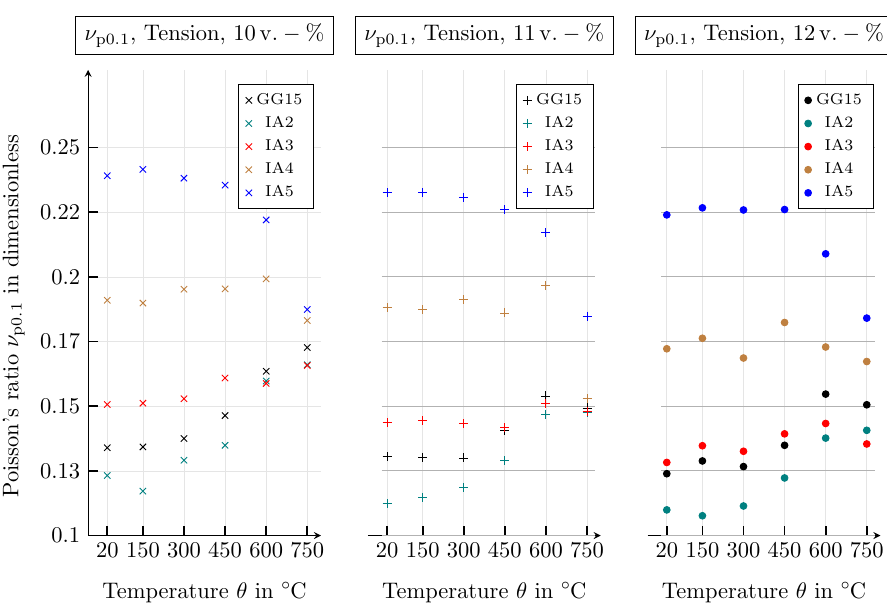
Figure 24. Poisson’s ratios of all graphite classes with graphite flake volume fractions of 10, 11 and 12v. %, evaluated for the temperatures 20, 150, 300, 450, 600 and 750°C, at a tensile strain of 0.1%. −